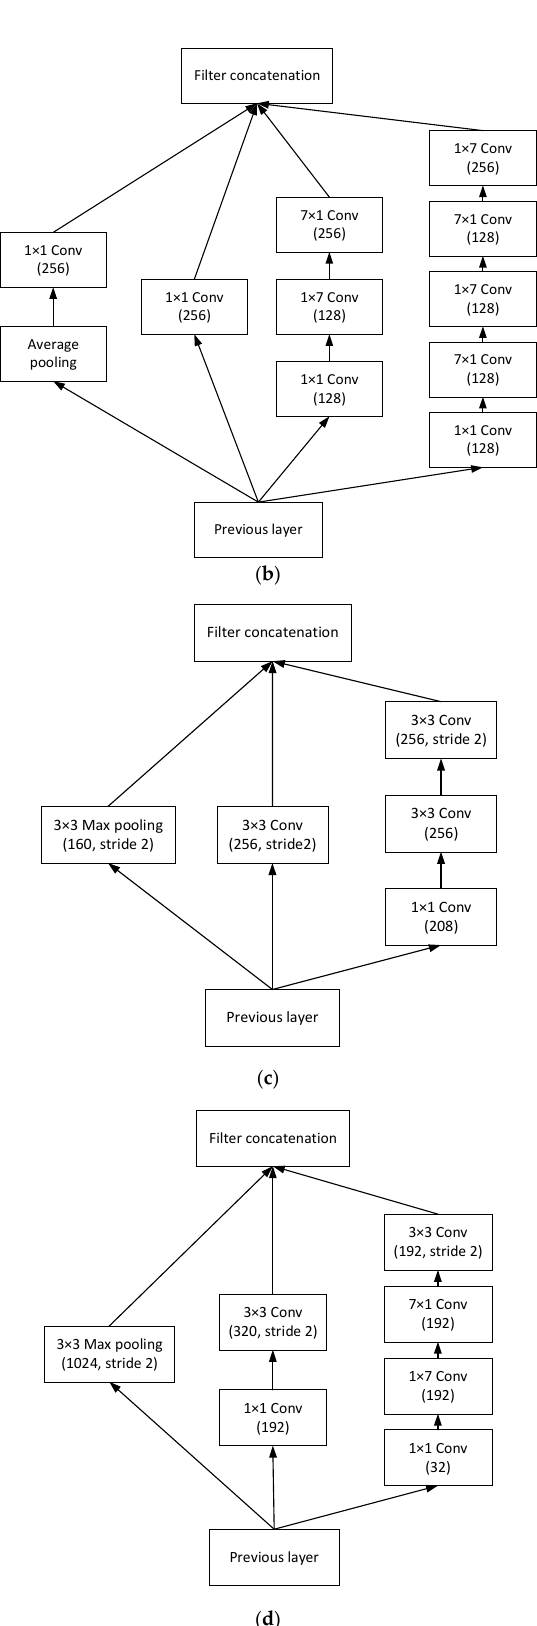
Figure A2. Block structure in the Inception network. ( a ) block A, ( b ) block B, ( c ) block C, ( d ) block